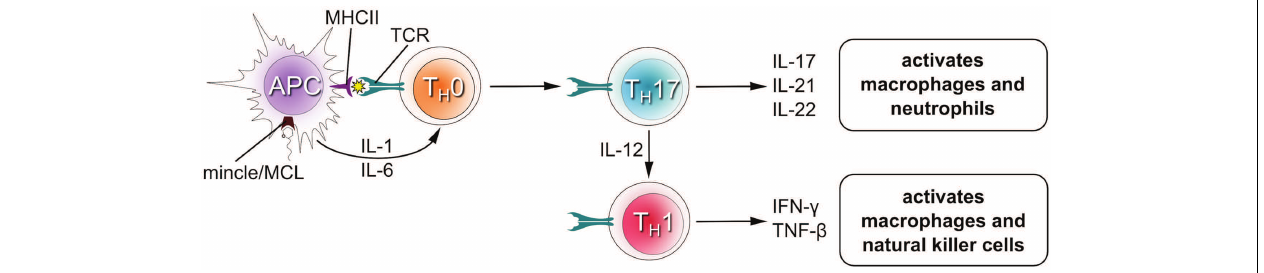
FIGURE 3 |T cell differentiation upon stimulation of Mincle/MCL .